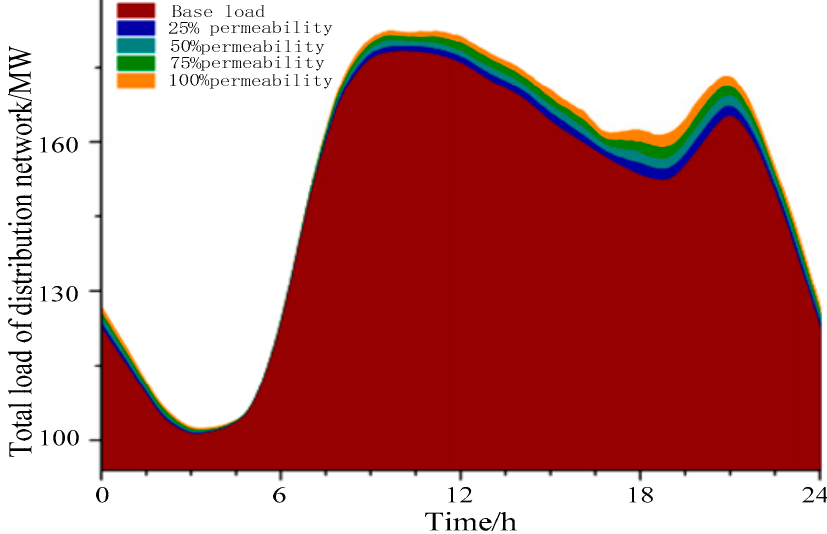
Figure 9. Overall load variation of distribution network under different permeability.